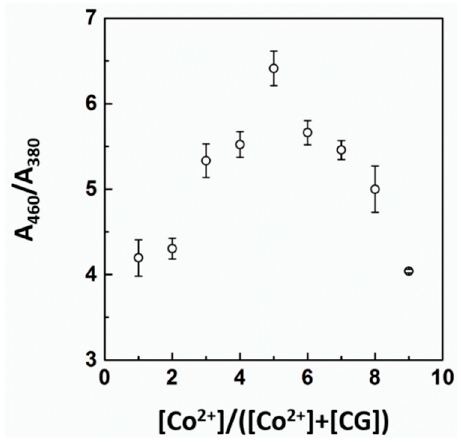
Figure 3. Job’s plot obtained between CG chemosensor and cobalt. The total concentration of the CG chemosensor and cobalt was 10 μ M. Each experiment was conducted three times.